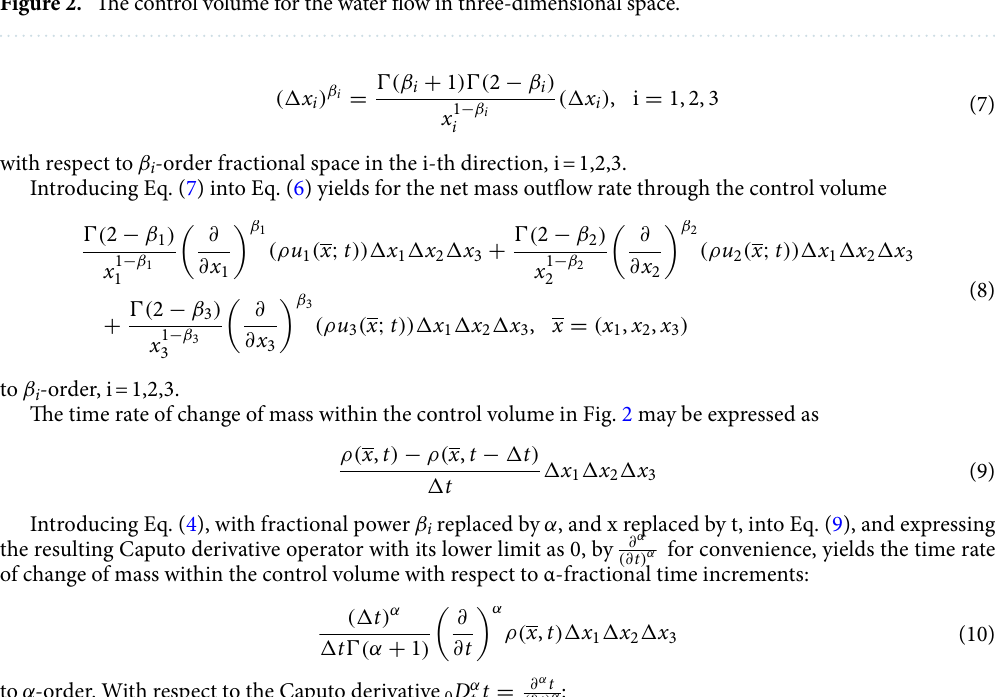
Figure 2. The control volume for the water flow in three-dimensional